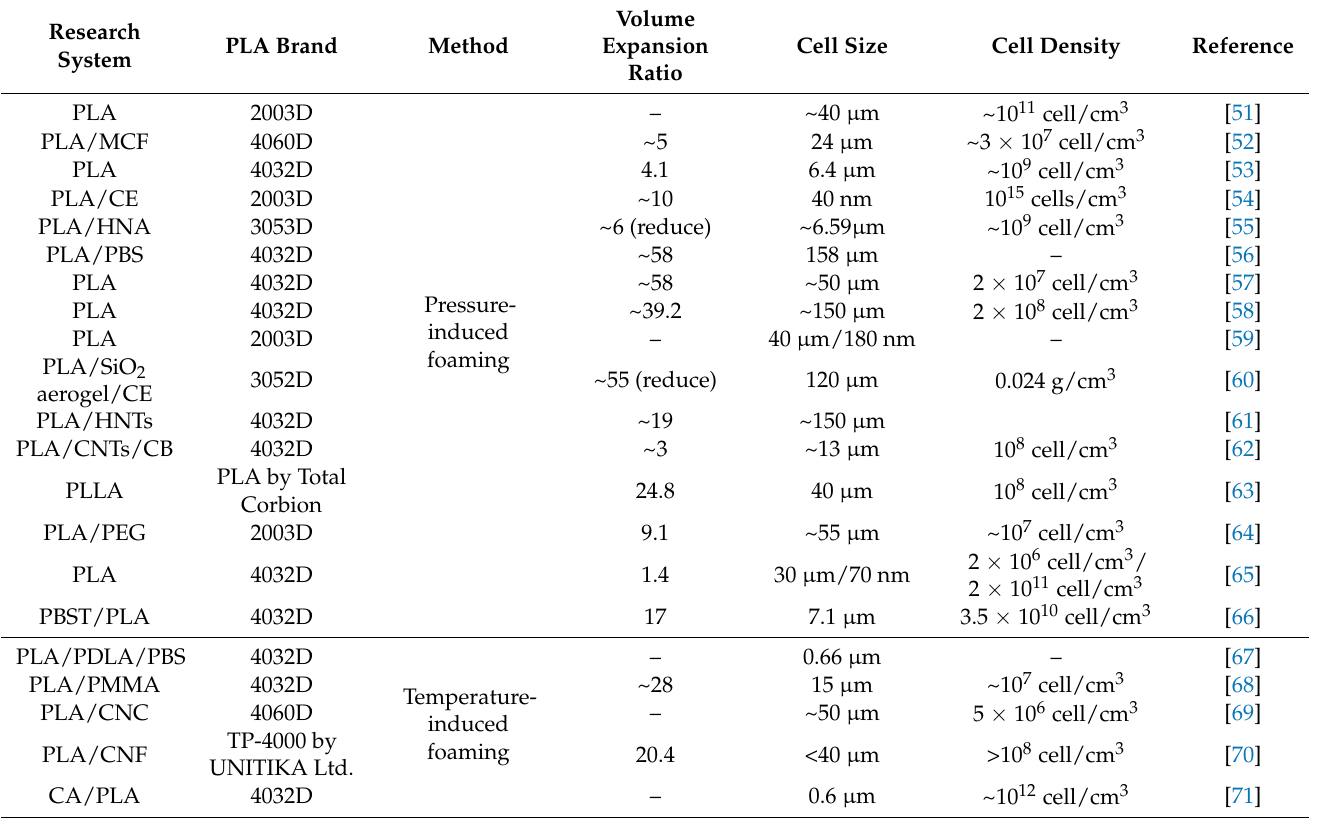
Table 1. Research work on the preparation of PLA and its composite foam materials by batch foaming method in the past 3 years. (PLA is from NatureWorks, USA. when not otherwise